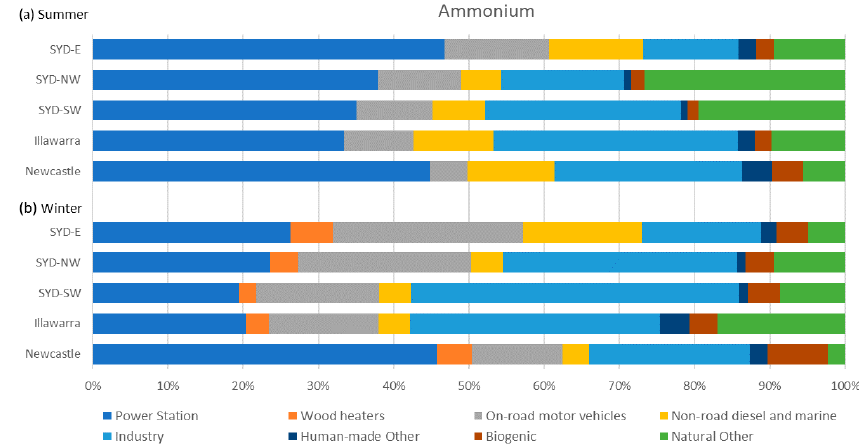
Figure 9. Regional average major source groups contribution (%) to ammonium mass in the Sydney East (SYD-E), Sydney Northwest (SYD-NW), Sydney Southwest (SYD-SW), Illawarra and Newcastle regions in ( a ) summer and ( b ) winter of